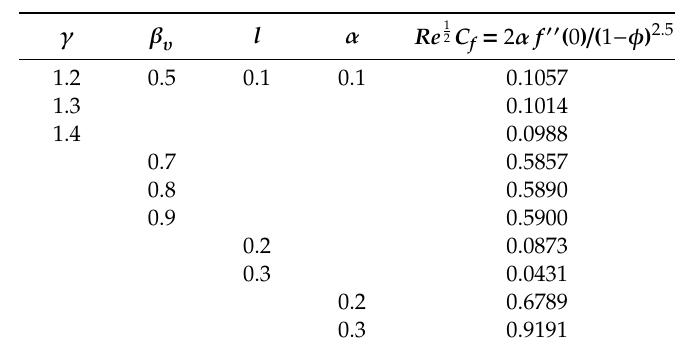
Table 3. Numerical values of drag force C f Re x 1/2 against the distinct estimates of parameters. i.e., δ = 0.5, S t = 0.5, and S = 0.5. 1 1